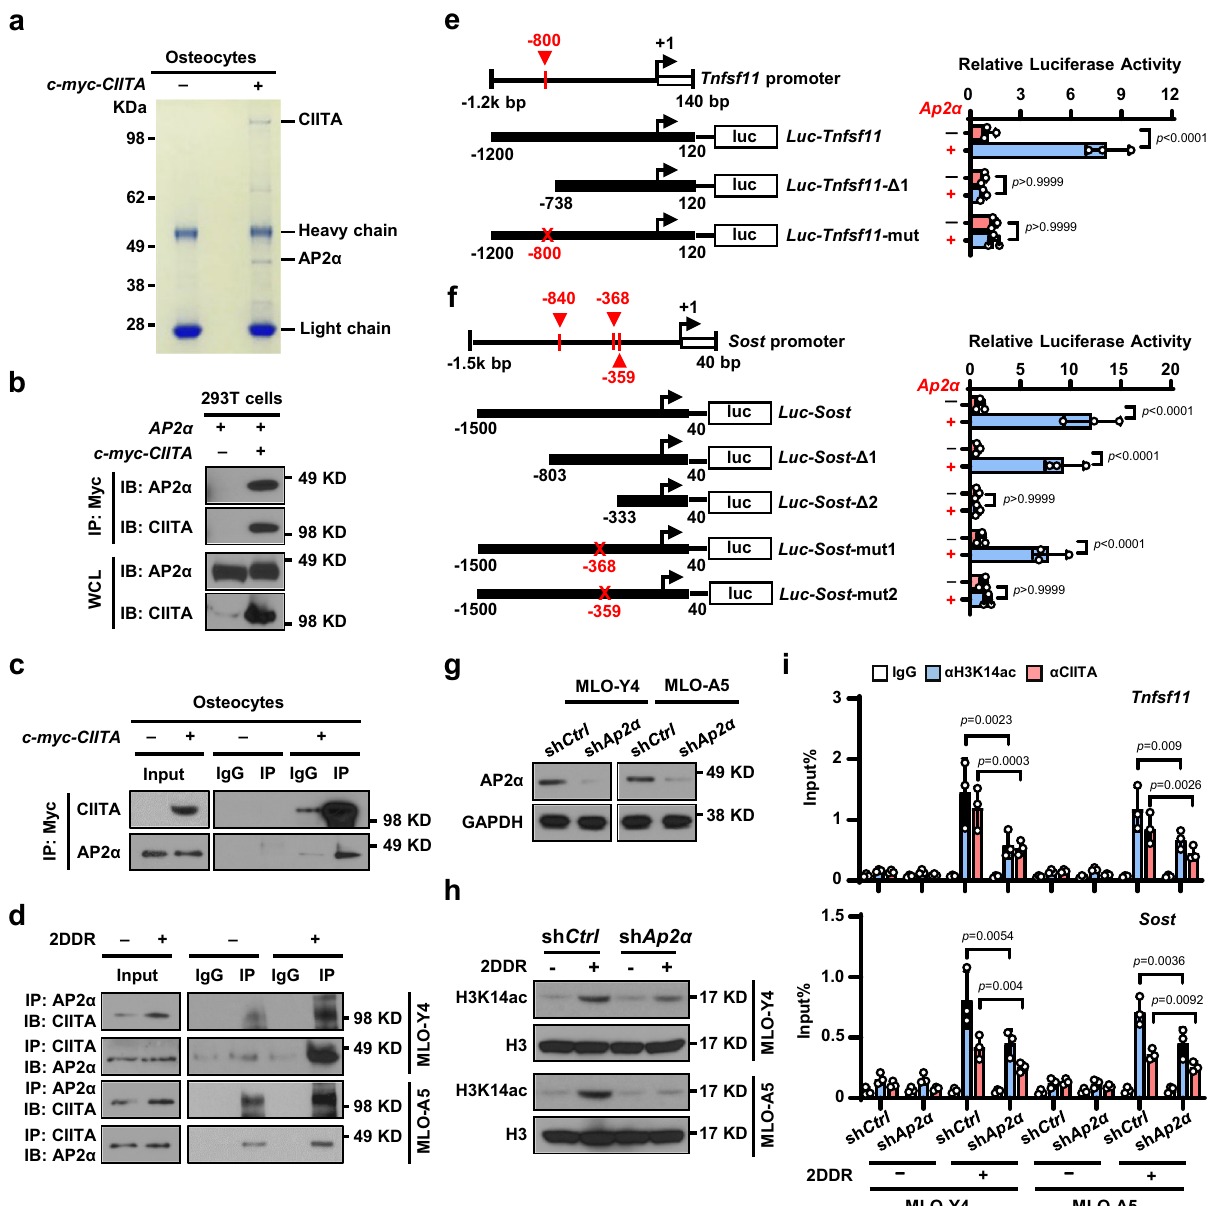
Fig. 6 AP2 α bridges the interaction between CIITA and the promoters of TNFSF11 and SOST in osteocytes. a Immunoprecipitates pulled down by c-myc- CIITA in osteocytes transfected with a c-myc – CIITA plasmid using Coomassie blue staining. b Pull-down of AP2 α with c-myc-CIITA in HEK293T cells. c Co- immunoprecipitation of CIITA with AP2 α in osteocytes transfected with c-myc-CIITA plasmid. d Co-immunoprecipitation of CIITA with AP2 α in MLO-Y4 and MLO-A5 osteocytes cultured without or with 1 mM 2DDR. e , f Schematic of the Tnfsf11 ( e ) and Sost ( f ) promoter luciferase reporter. Solid boxes: promoter region; red crosses: mutation sites. The luciferase activity of Luc-Tnfsf11 or Luc-Sost constructs was set at 1. ns, not signi fi cant. g – h Western blot shows the expression of AP2 α ( g ) and H3K14ac ( h ) in MLO-Y4 or MLO-A5 cells transfected with non-targeted shRNA (sh Ctrl ) or Ap2 α shRNA (sh Ap2 α ) cultured without or with 1 mM 2DDR. (GAPDH and H3: protein loading controls). i ChIP assay shows the enrichment of H3K14ac and CIITA in the promoter of Tnfsf11 or Sost genes in MLO-Y4 and MLO-A5 cells expressing sh Ctrl or sh Ap2 α cultured without or with 1 mM 2DDR. Data in ( e ), ( f ), and ( i ) are presented as mean ± SD, n = 3 biological replicates. P values were determined using one-way ANOVA with Tukey ’ s multiple comparisons test. Data shown in ( a – d ), ( g ), and ( h ) are representative of two independent